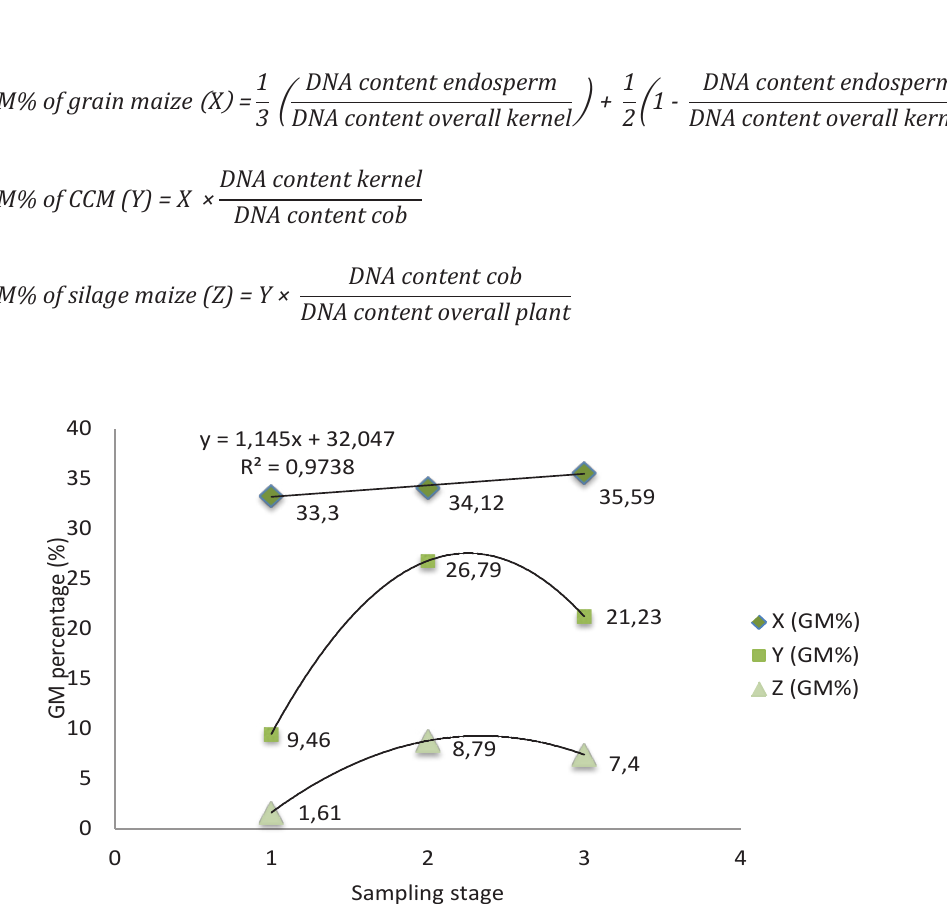
Fig. 4. Expected GM percentage, provided that there is perfect (100%) cross-pollination with GM maize, on three different sampling stages for different maize usages. X= grain maize, Y= corn cob maize (CCM), Z= silage